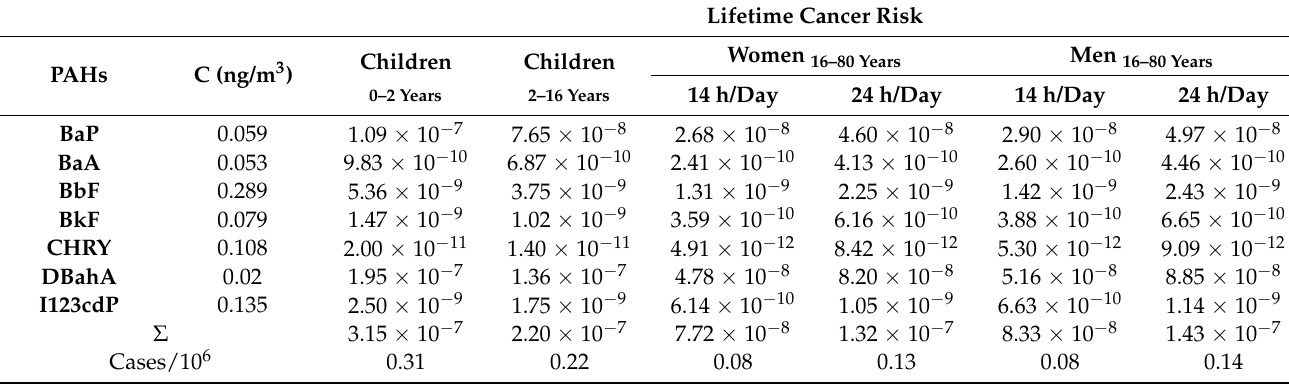
Table A2. Cancer risk assessment A.II method (Maertens, 2004).